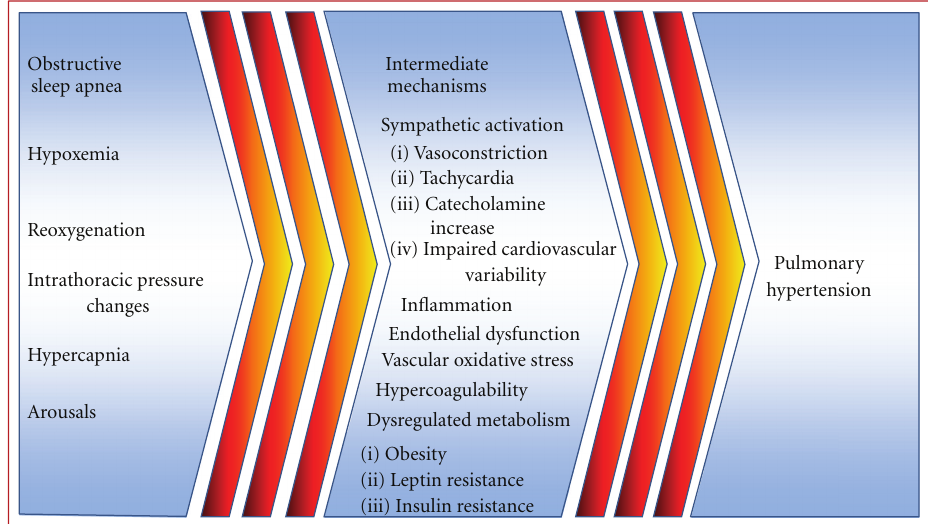
Figure 2: Intermediate mechanisms which potentially increase the risk of developing pulmonary hypertension in obstructive sleep apnea. These intermediate mechanisms in obstructive sleep apnea may contribute to initiating and perpetuating pathologic cardiovascular changes which result in pulmonary